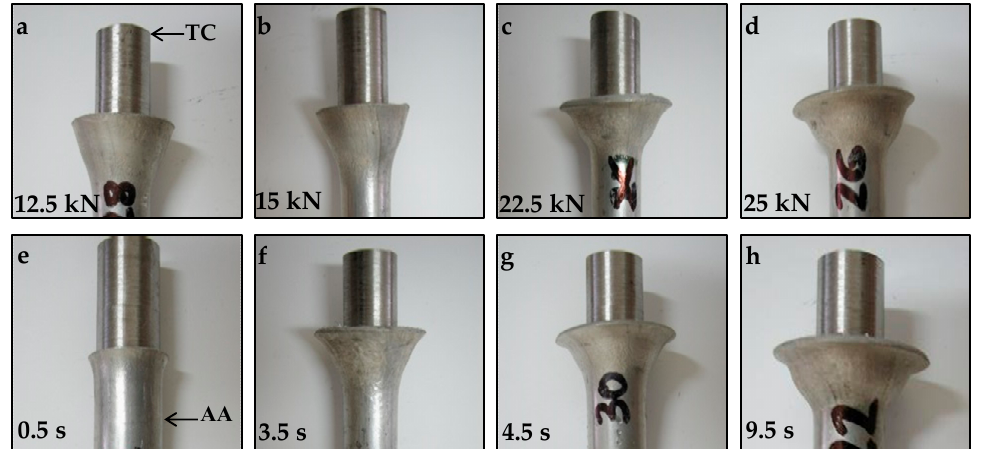
Figure 4. The appearance of the TC/AA joints at various friction forces and at a constant friction time equal to 9.5 s ( a – d ), and the influence of various friction times at a constant friction force equal to 12 kN ( e – h ).